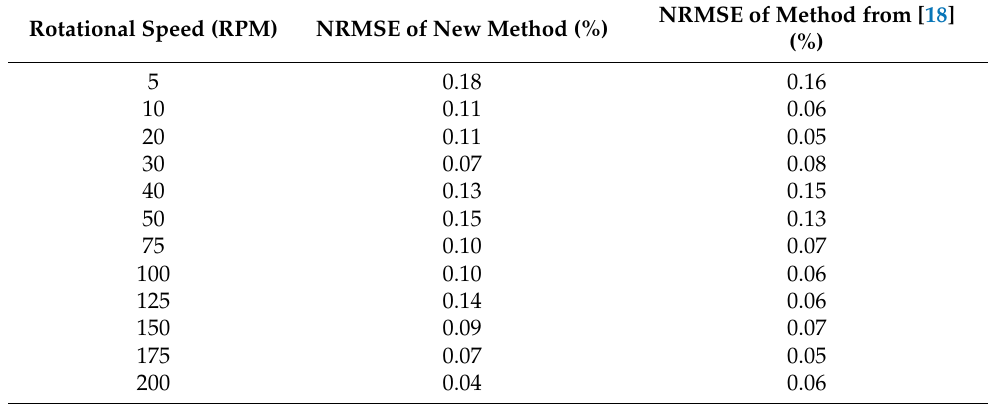
NRMSE of Method from